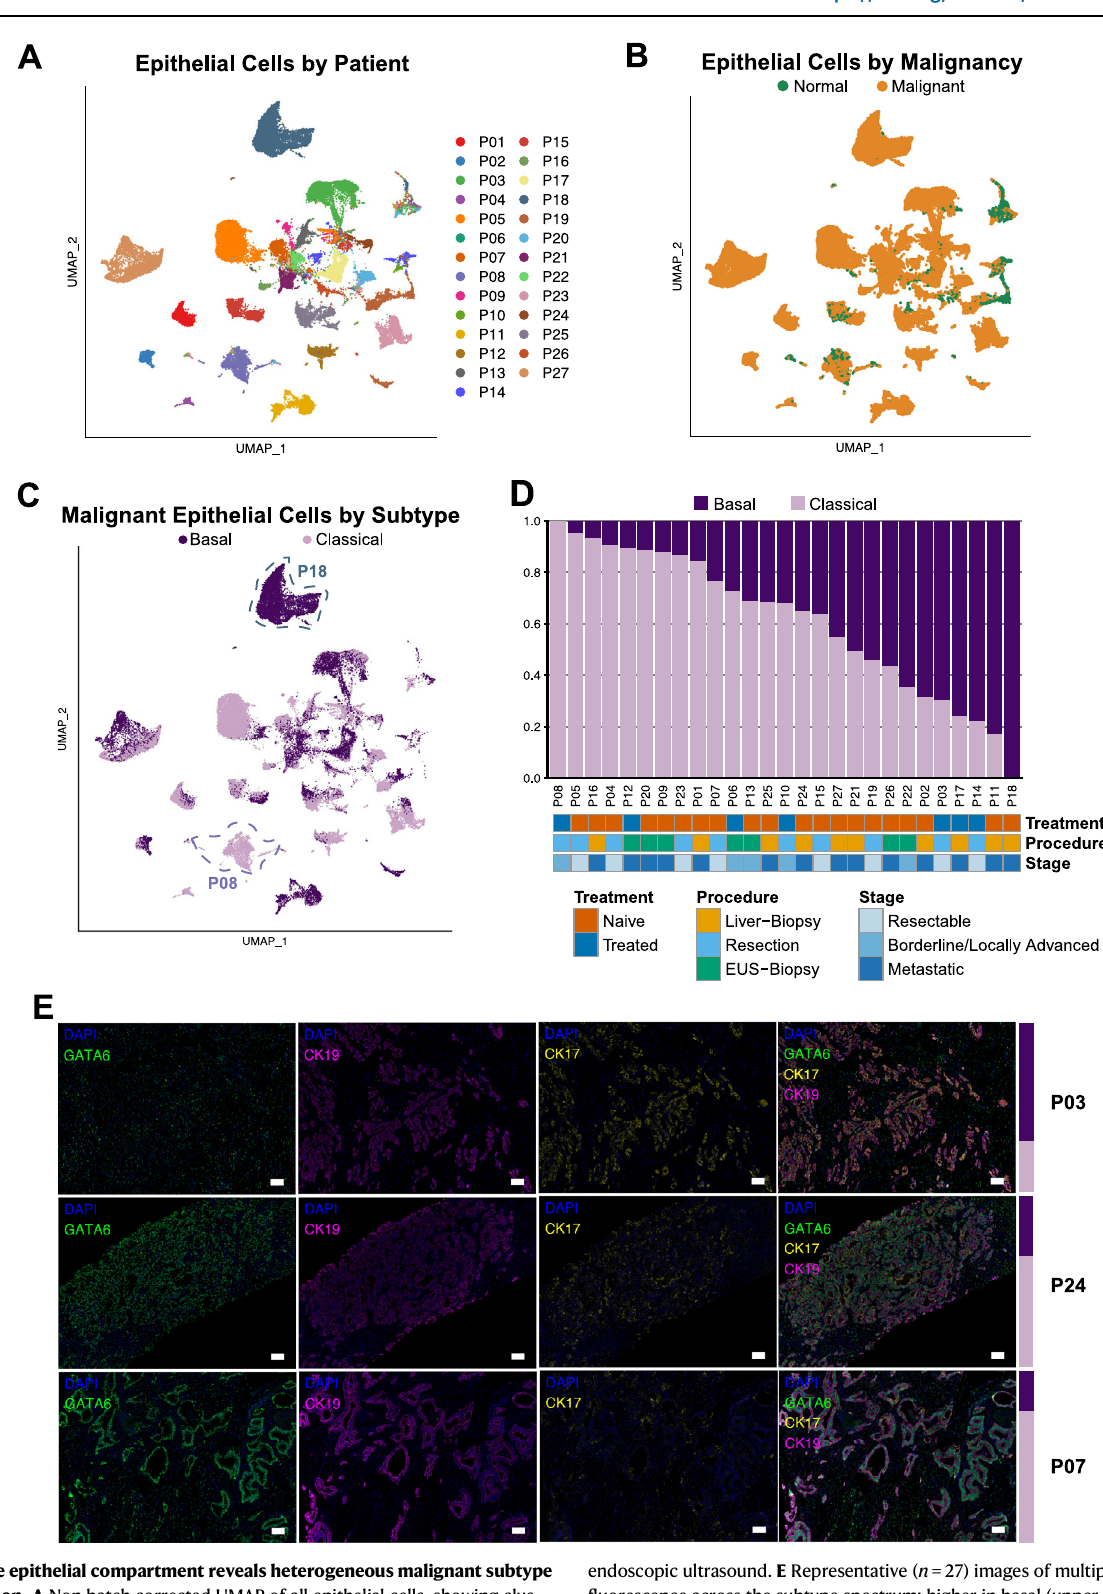
endoscopic ultrasound. E Representative ( n =27) images of multiplex immuno- fl uorescence across the subtype spectrum: higher in basal (upper panel, P03), mixed (middle panel, P24), and higher in classical (lower panel, P07) subtype tumors. Basal-to-classical ratio for each sample by scRNA-seq transcriptional ana- lysisisshownontherightasacoloredbar(dark=basal,light=classical).Channels (alwaysincludingDAPI(blue)):GATA6(green),CK19(cytokeratin19)(violet),CK17 (cytokeratin 17) (yellow), and merged. Scale bar=100 μ m.